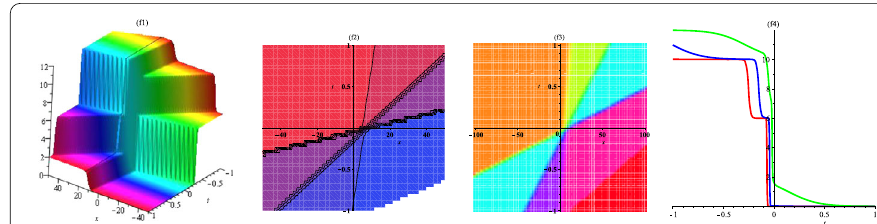
Figure 8 Diagram of 3-lump (2.20) by taking k 1 = 1, k 2 = 2, k 3 = 3, α = 0.1, (cid:14) = –1, τ = 2, η 10 = η 20 = η 30 = 0, R = 2, y = –2 at space (red x = –1, blue x = 0, and green x = 1)